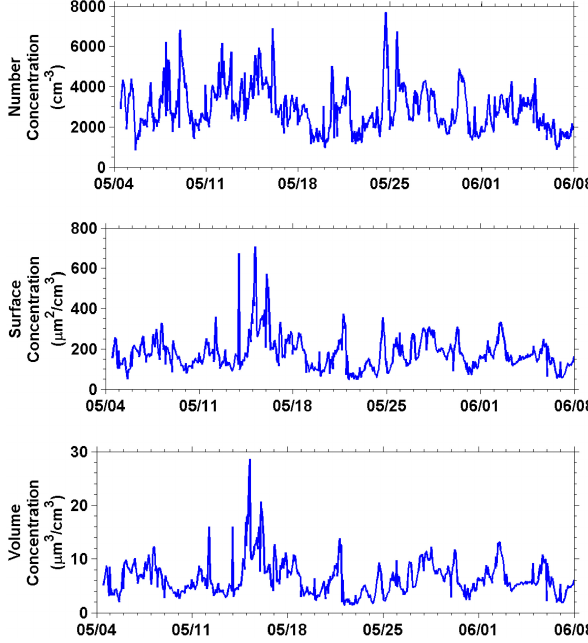
Fig. 13. Time series of number, surface area and volume concentra- tions for N 10 − 500 .